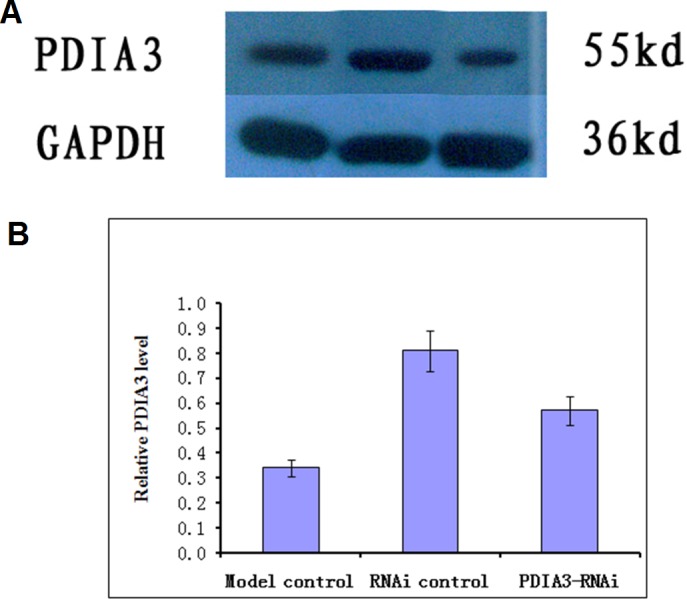
Western blot analysis of PDIA3 in IBS models after PDIA3 knockdown with RNAi.(A) Representative Western blots; (B) PDIA3 expression relative to GADPH. Control, rat models injected with saline solution; empty vector, rat models injected with empty vector; RNAi-PDIA3, rat models injected RNAi-PDIA3. All experiments were repeated three times, and difference in the PDIA3 expression levels were analyzed using t-test. ## denotes significant difference (P < 0.05) vs control or empty vector.